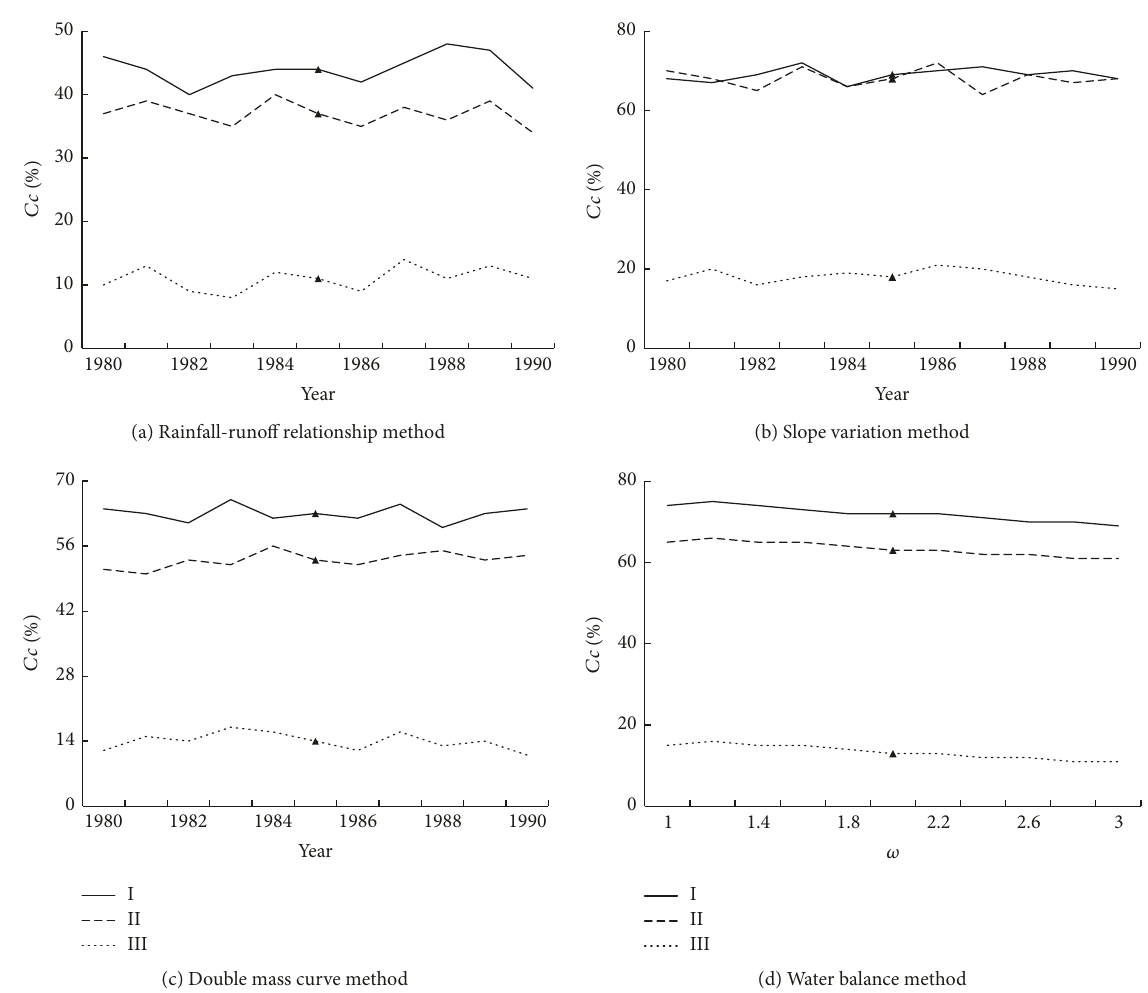
Figure 5: Adaptability in rainfall-runoff relationship, slope variation, double mass curve, and sensitivity in water balance